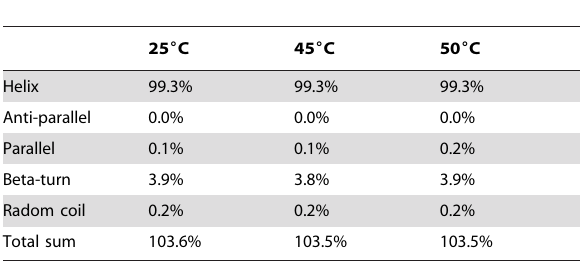
Table 1. CDNN analysis of the CD